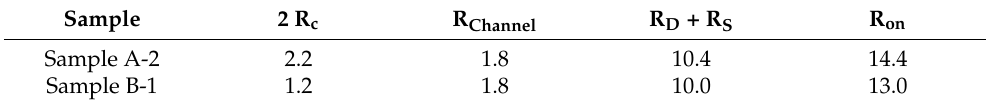
Figure 5. ( a ) The transfer I-V characteristics of Sample B-1 and Sample A-2 under V D = 10. ( b ) Off-state leakage current characteristics. Table 2. Measured value of series resistances of fabricated GaN